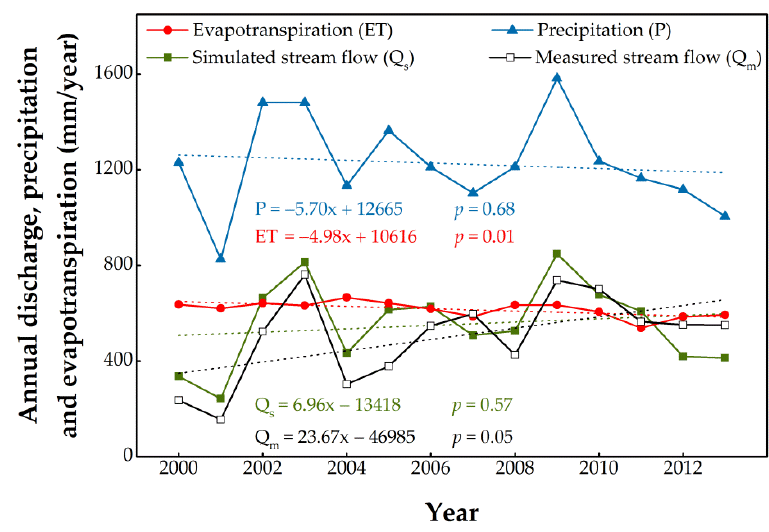
Figure Figure 11. Changes of annual measured stream flow (Q m ), simulated stream flow (Q s ), evapotranspiration (ET), and precipitation (P) for the Qinhuai River basin from 2000 to 2013.